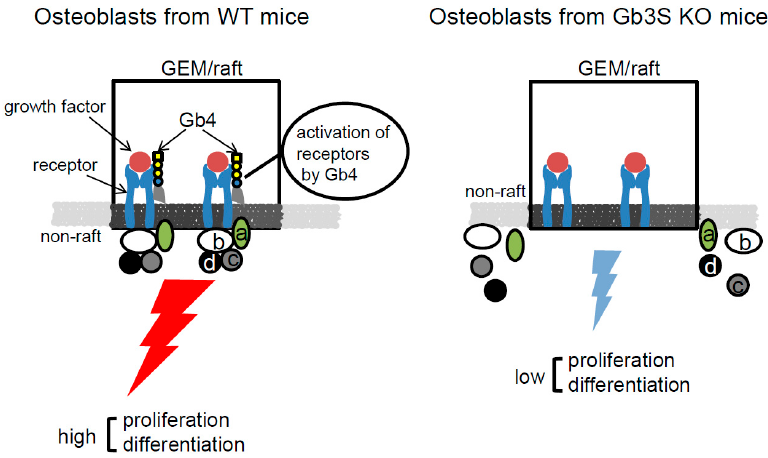
Figure 9. Schematic illustration of the proposed regulation of proliferation and/or differentiation of osteoblasts by Gb4.